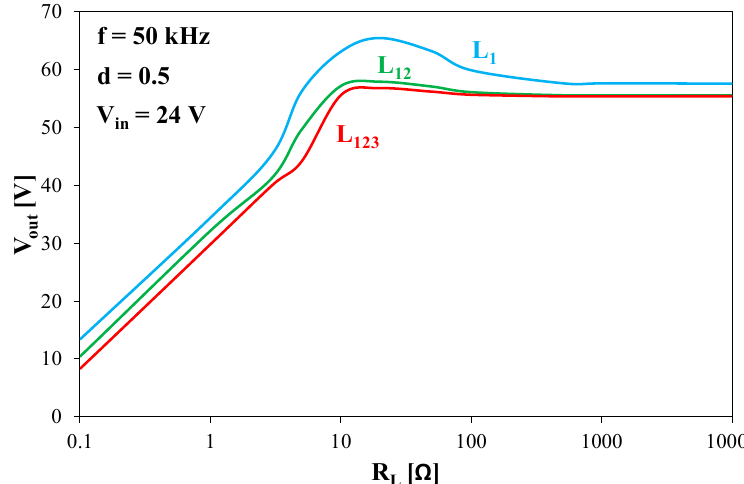
Figure 18. Dependence of the output voltage on the load resistance of the boost converter when the current flows through one coil, two coils, or three coils connected in series.